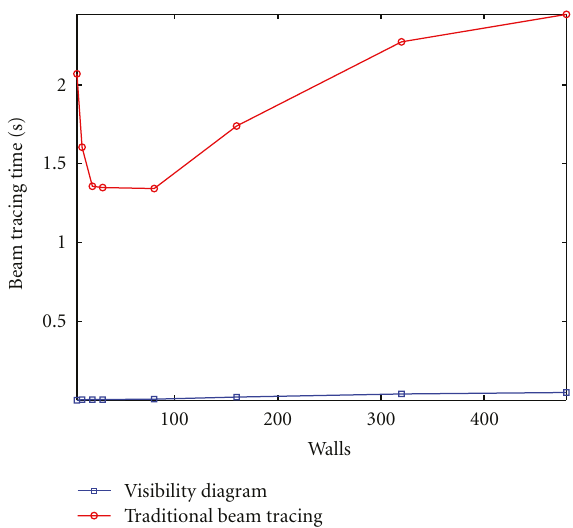
Figure 14: Beam-tree building time for variable geometry for traditional beam tracing (circles) and visibility-based beam tracing (squares) for 10,000 beams. The proposed approach greatly out- performs traditional beam tracing especially when the number of traced beams is very large.